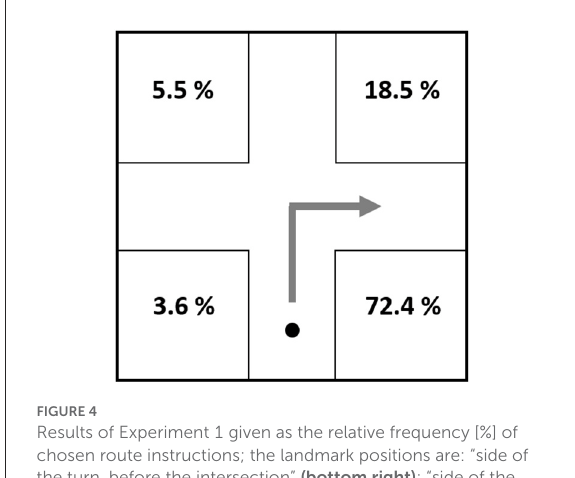
FIGURE4 Results of Experiment 1 given as the relative frequency [%] of chosen route instructions; the landmark positions are: “side of the turn, before the intersection” (bottom right) ; “side of the turn, behind the intersection” (top right) ; “opposite side of the turn, behind the intersection” (top left) ; “opposite side of the turn, before the intersection” (bottom left) .